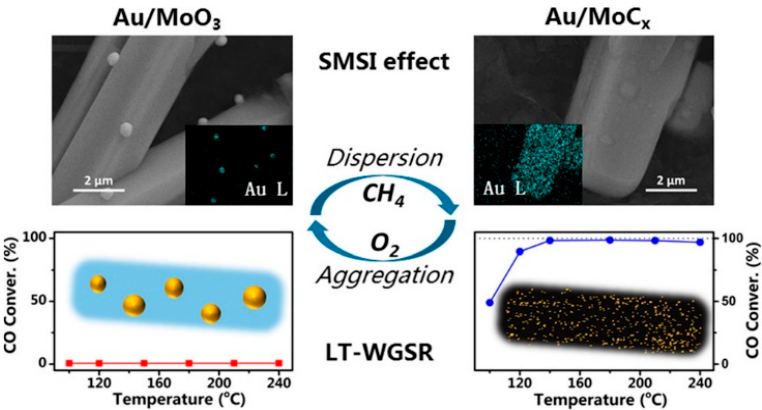
Figure 11. Illustration of the SMSI effect between Au overlayers and carbide supports. Reproduced with permission from [78], copyright: 2018 by the American Chemical Society.